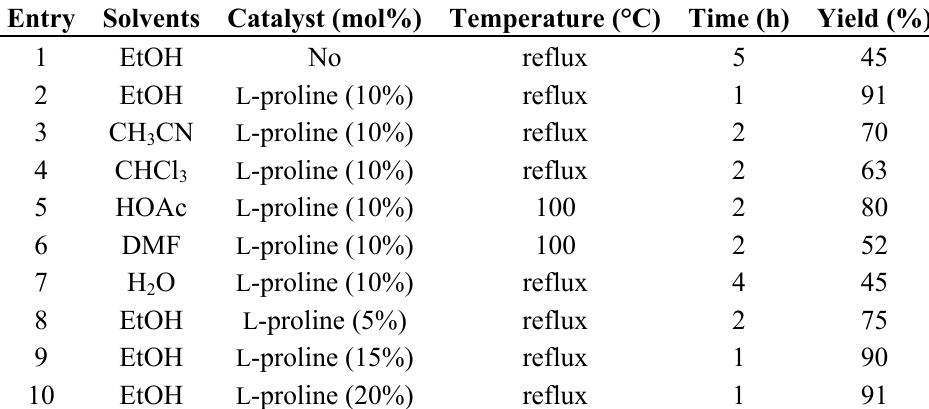
Table 1. Optimization of reaction